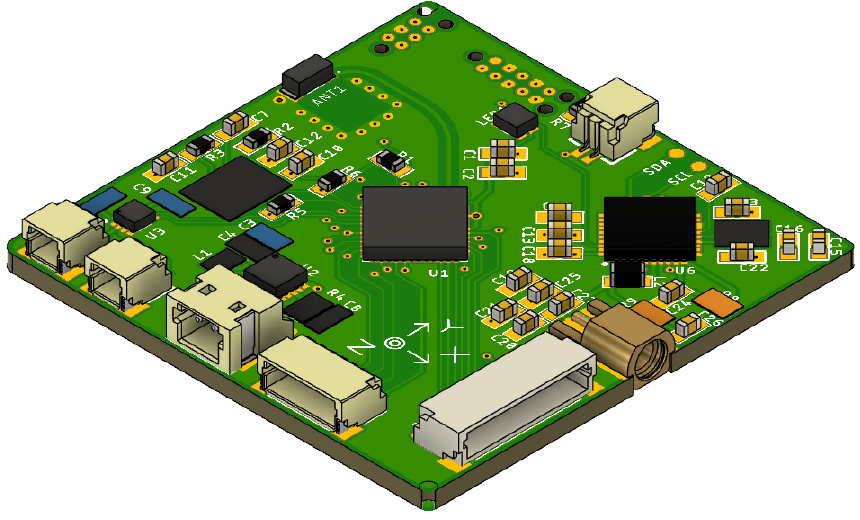
Figure 3. The final design of the main PCB.